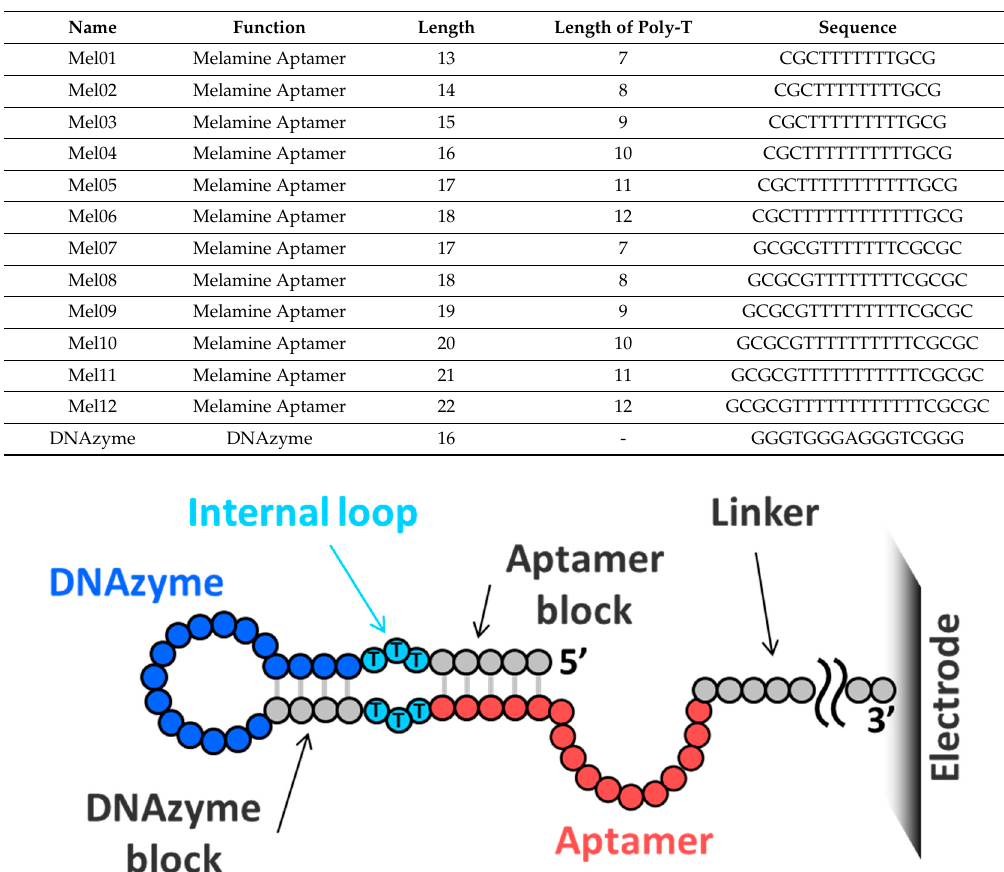
Figure 1. A schematic representation of the design of an aptamer-DNAzyme conjugated biosensor for microarray screening. The designed biosensor comprises an aptamer region (red), a DNAzyme region (blue), an internal loop region (cyan), two block sequences (gray) for the aptamer and the DNAzyme, and a linker region, immobilized on the microarray electrode. Table 1. Melamine aptamers modified from the original poly-T melamine aptamer and a designed peroxidase-mimicking DNAzyme used for screening.